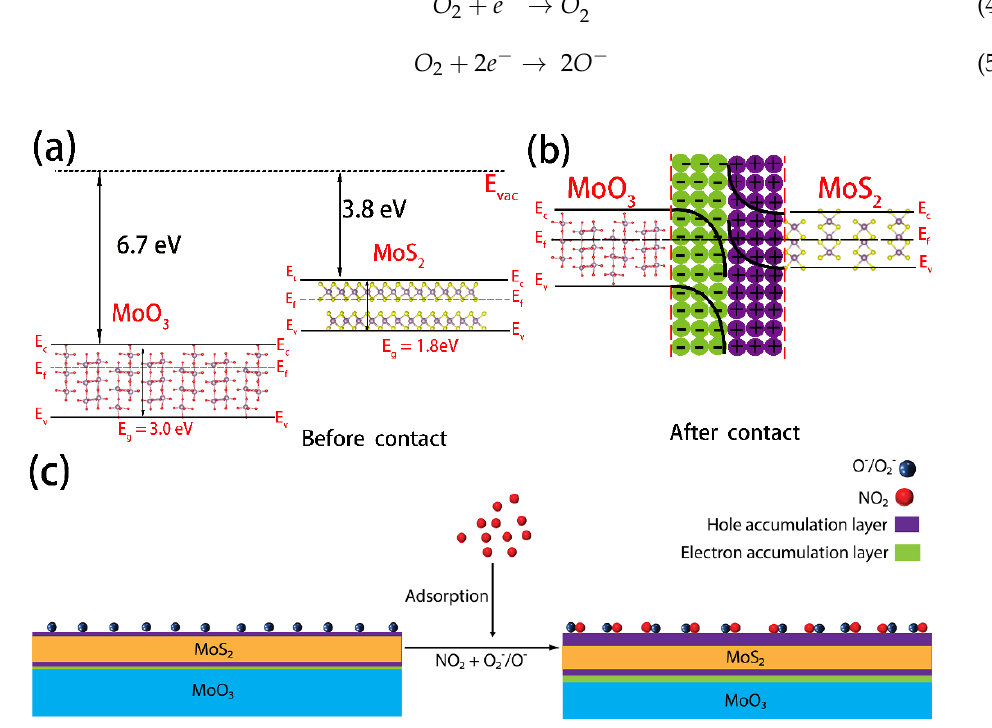
Figure 9. The energy band diagram of MoS 2 @MoO 3 heterostructure ( a ) before contact, ( b ) after contact; ( c ) gas-sensing mechanism of MoS 2 @MoO 3 heterostructure.